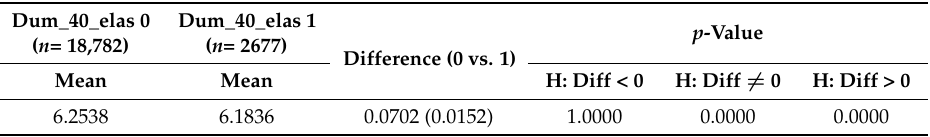
Table 6. Difference test of means in logarithm of hourly consumption by Dum_40_elas variable. Dum_40_elas 0 ( n = 18,782)